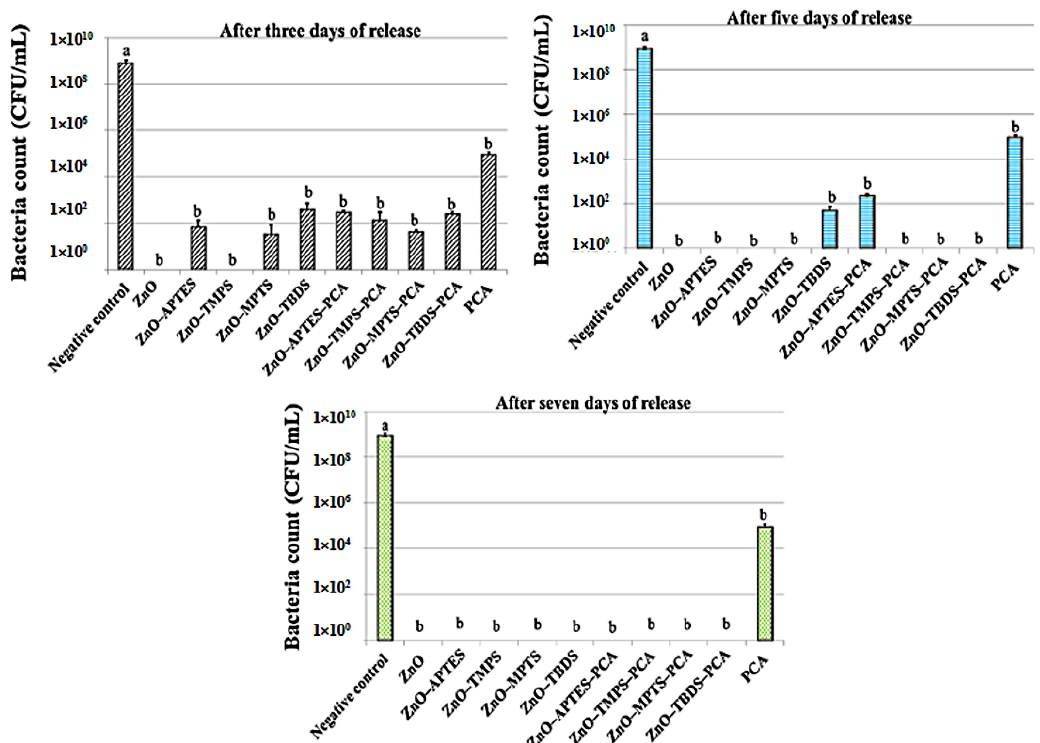
Figure 8. Results of the log reduction assay of ZnO NPs, surface-modified NPs, nanoformulations, PCA antimicrobial activity of the solutions (supernatants) obtained after three, five, and seven days against S. aureus . Columns labeled with different letters (a, b) had significantly different average values ( p ≤ 0.05). Materials marked by the same letter (for instance, “a”) displayed no significant differences. Materials marked with different letters (for instance, “a” for one material and “b” for another material) displayed significant differences.